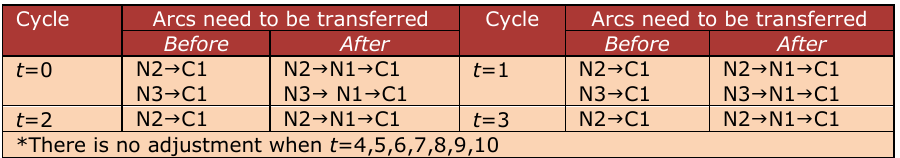
Table 4. Transferred arcs in each rescue cycle